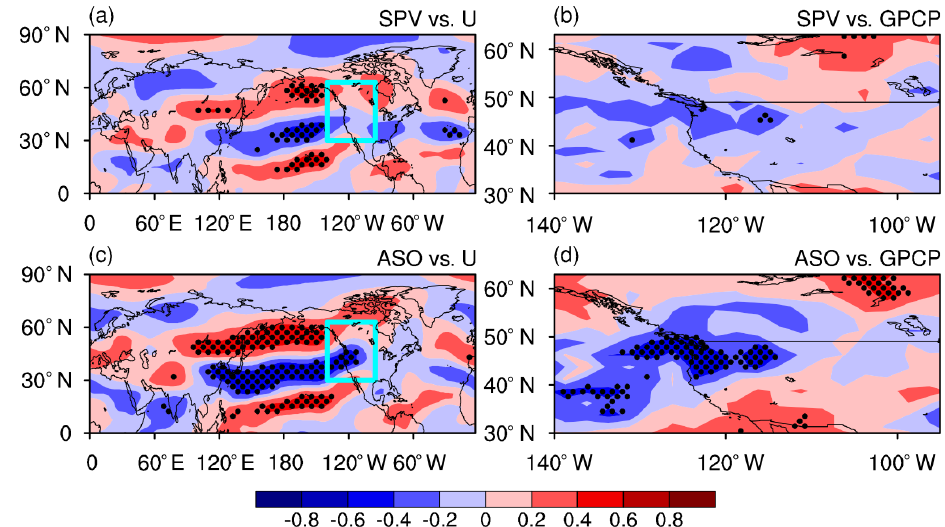
Figure 13. (a) Correlation coefficients between the index of February SPV multiplied by − 1 (10 5 Km 2 kg − 1 s − 1 ) defined by Zhang et al. (2018) and April zonal wind variations at 200hPa for 1984–2016. (b) Correlation coefficients between the index of February SPV multiplied by − 1 and April precipitation variations. In (c) and (d) , it is the same as for (a) and (b) but between March ASO and April 200hPa zonal wind and April precipitation variations. Dots denote significance at the 95% confidence level, according to the Student’s t test. The long-term linear trend and seasonal cycle in all variables were removed before the correlation analysis. The ASO data are from SWOOSH, zonal wind from NCEP-2 and precipitation from